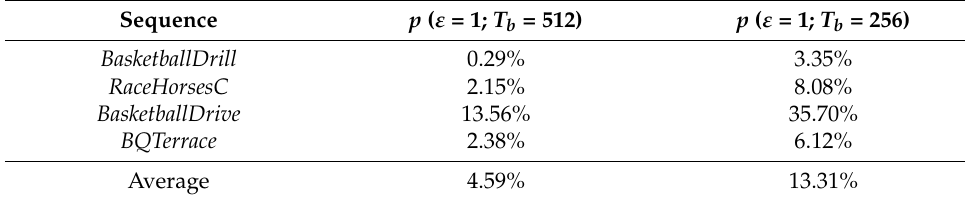
Table 1. Prior probability of block size (QP = 27).